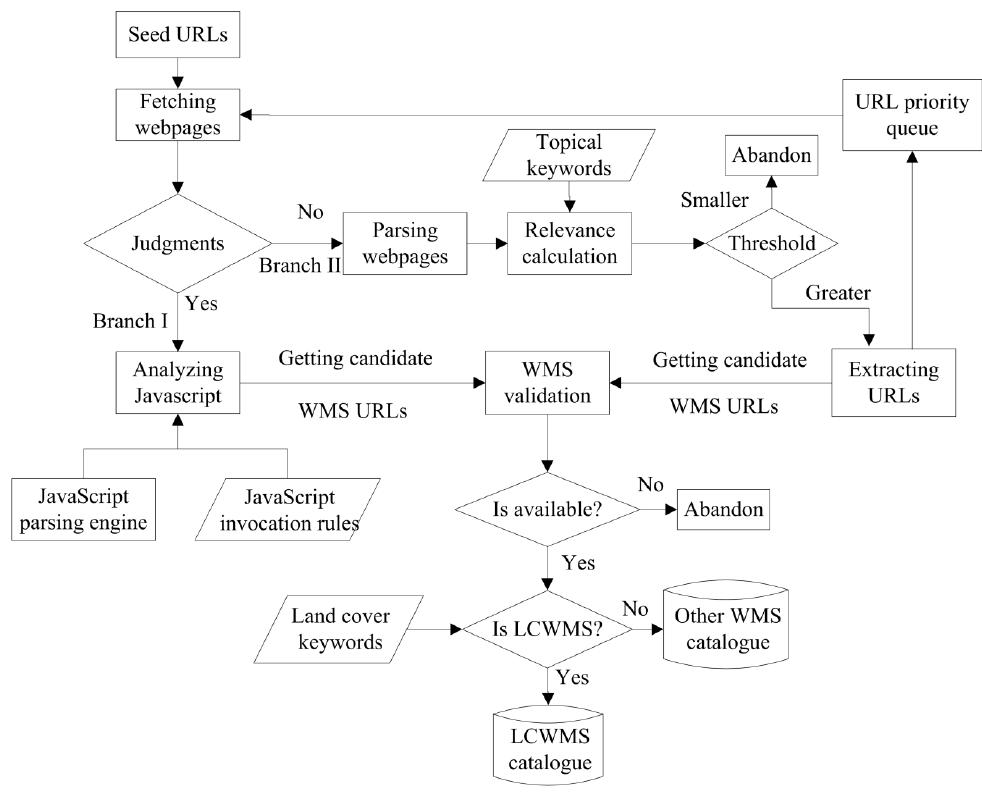
Figure 6. The framework of the focused deep web crawler for active discovery of LCWMSs.